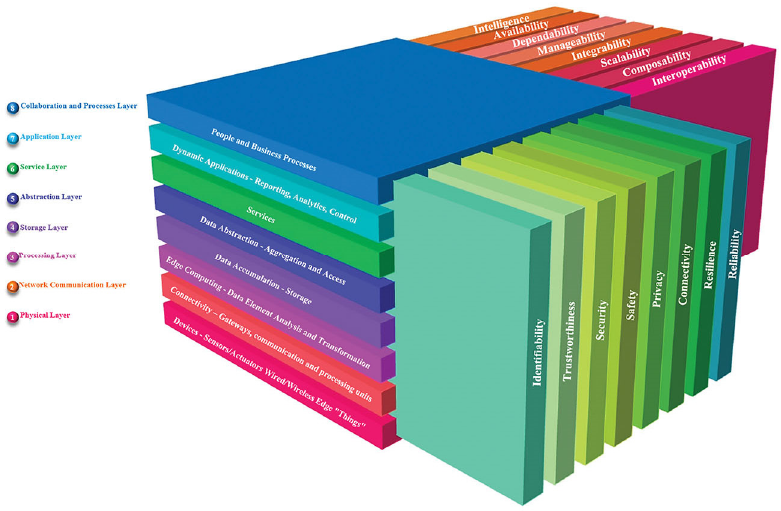
Figure 4. The general structure of CREATE-IoT 3D RAM (Reprinted from ref. [51]).